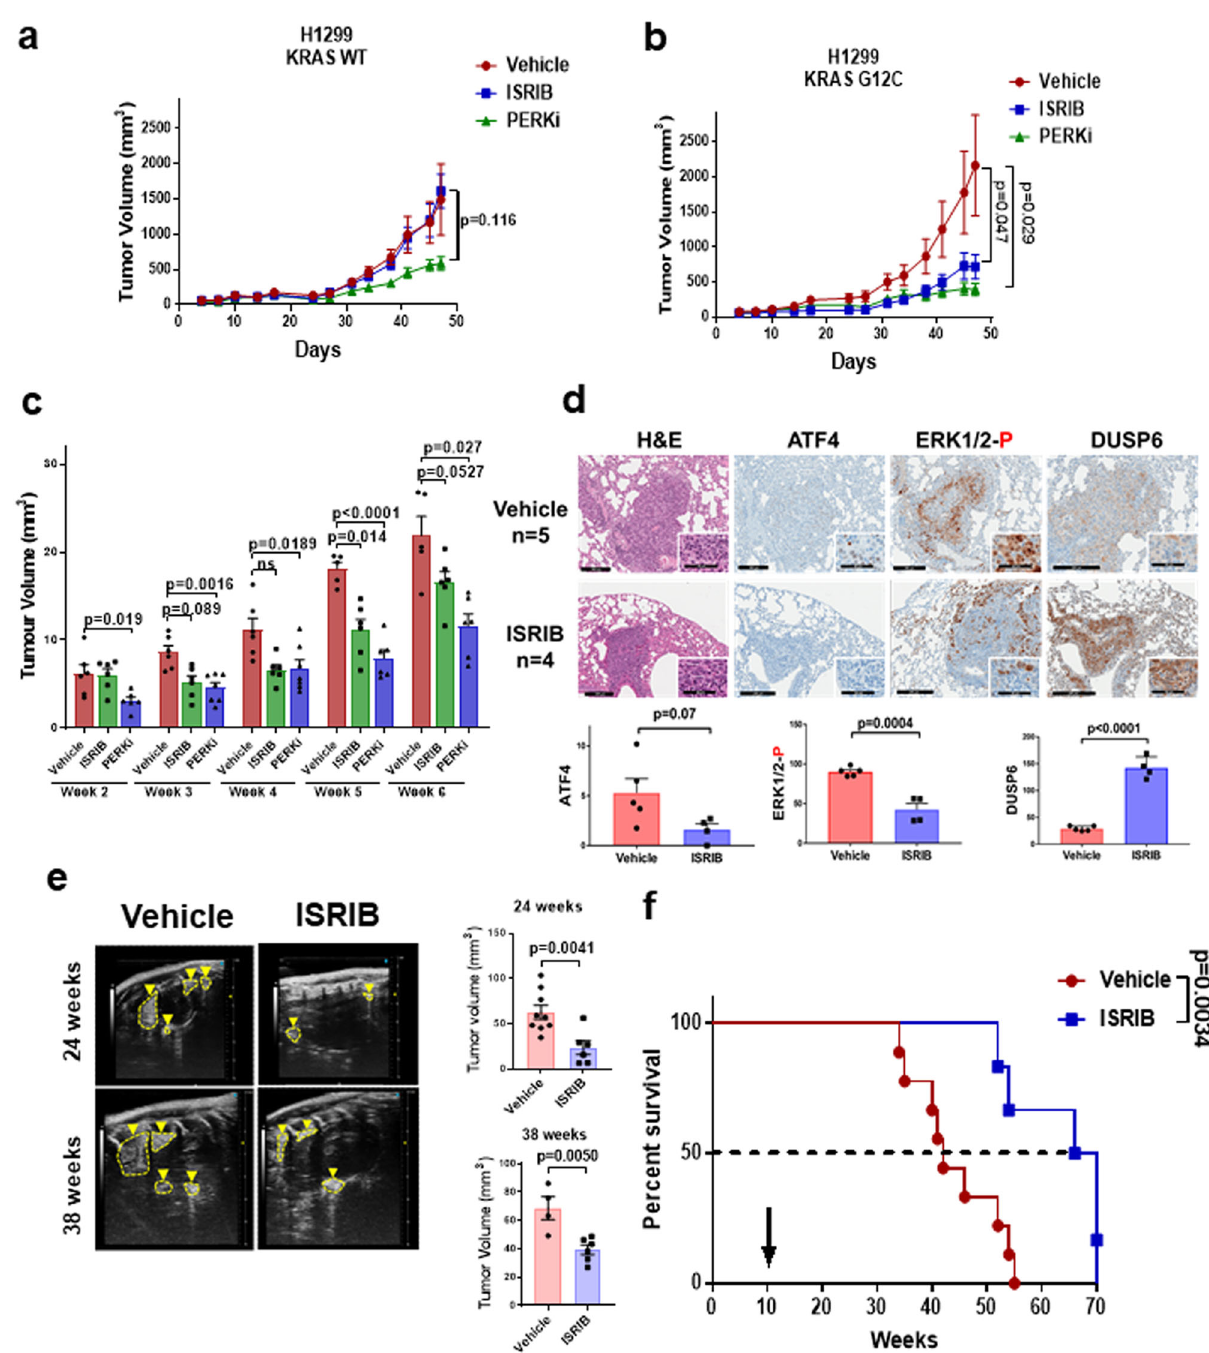
Fig. 5 ISR inhibition antagonizes p-eIF2 α function in mutant KRAS lung tumor cells. a , b Mouse KRAS G12D eIF2 α S/S and eIF2 α A/A cells ( a ) or human LUAD cell lines with either WT KRAS or KRAS G12C ( b ) were left untreated or pre-treated with 1 µ M thapsigargin (TG) for 30 min followed by treatments with increasing ISRIB concentrations for 1 h. Protein extracts (50 µ g) were subjected to immunoblotting for the indicated proteins. Quanti fi cations of blots for phosphorylated ERK (ERK-P) and DUSP6 in eIF2 α S/S and eIF2 α A/A cells were obtained from four biological replicates. ERK-P was normalized to total ERK whereas DUSP6 expression to Tubulin. One biological replicate consisted of eIF2 α S/S and eIF2 α A/A samples analyzed on the same blot shown in a whereas the rest of the biological replicates consisted of eIF2 α S/S and eIF2 α A/A samples derived from the same sets of experiments analyzed on separate blots but processed in parallel. ATF4 was used as a marker of the antagonistic effects of ISRIB on p-eIF2-mediated mRNA translation in the tumor cells. Data represent mean ± SEM. Signi fi cance in differences between two datasets was determined using two-tailed unpaired t- test. P values are indicated on the bar